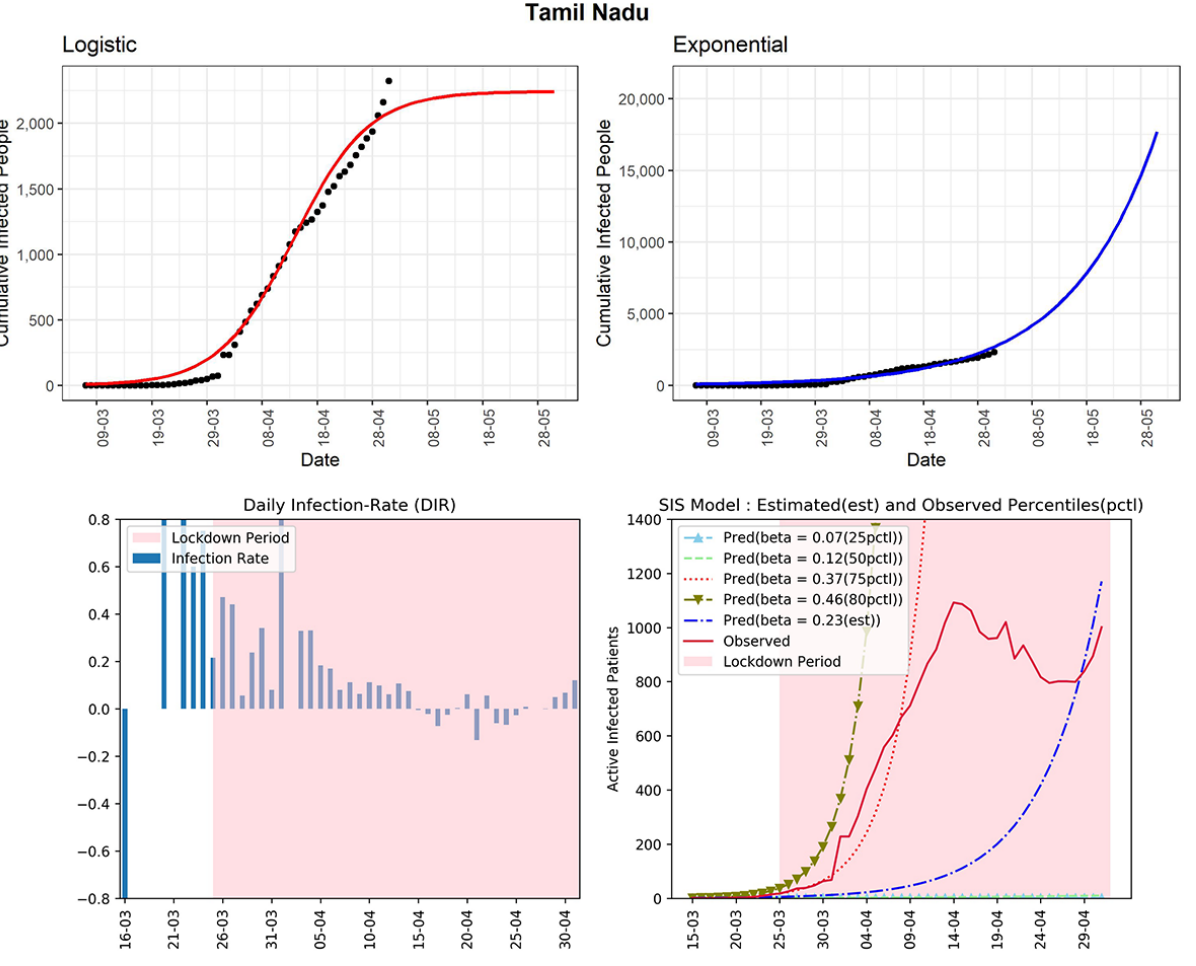
Figure 6. Graphs for the state of Tamil Nadu. SIS: